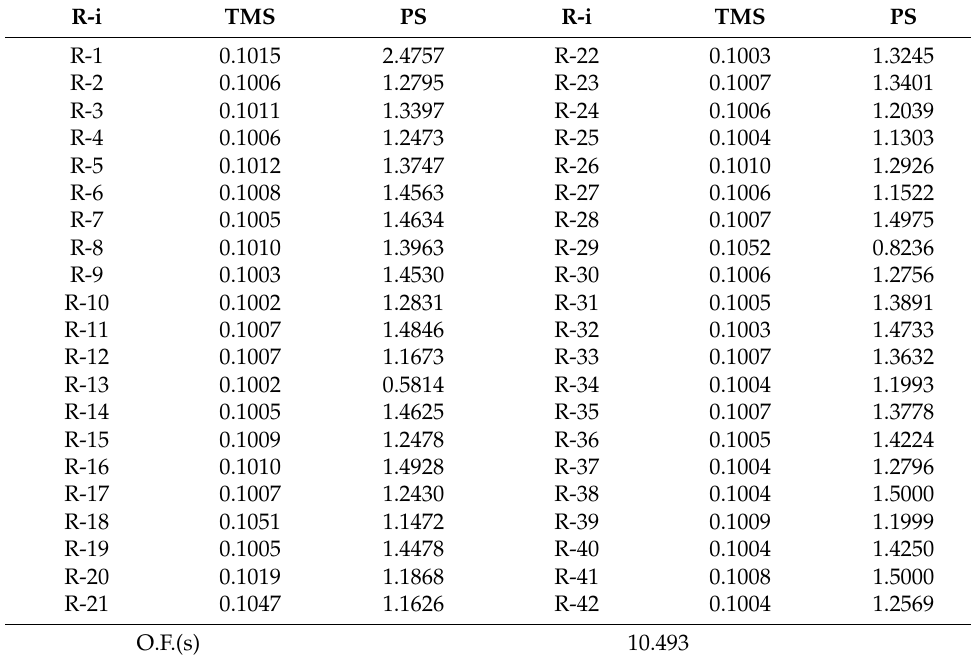
Table 7. Optimal values of TMS and PS (15-Bus